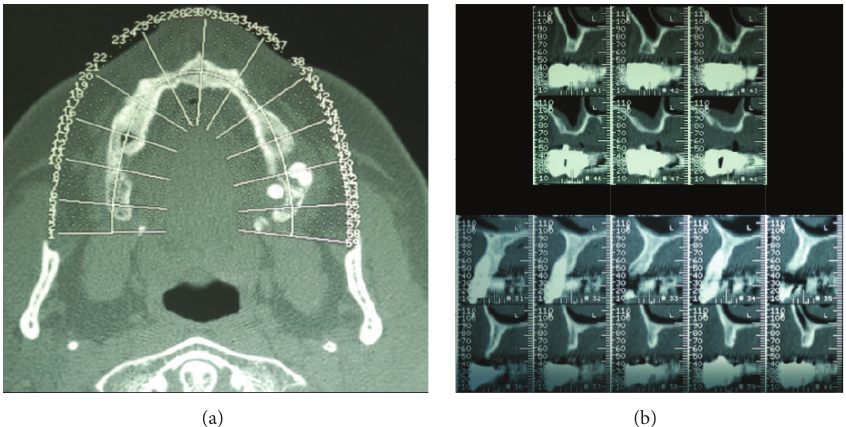
Figure 2: The CT dental scan confirms the clinical view showing atrophic maxillary ridge with important horizontal bone defect. (a) It is possible to underline all the atrophies of the upper maxilla; (b) a particular of the axial section of the area involved in the grafting procedures.